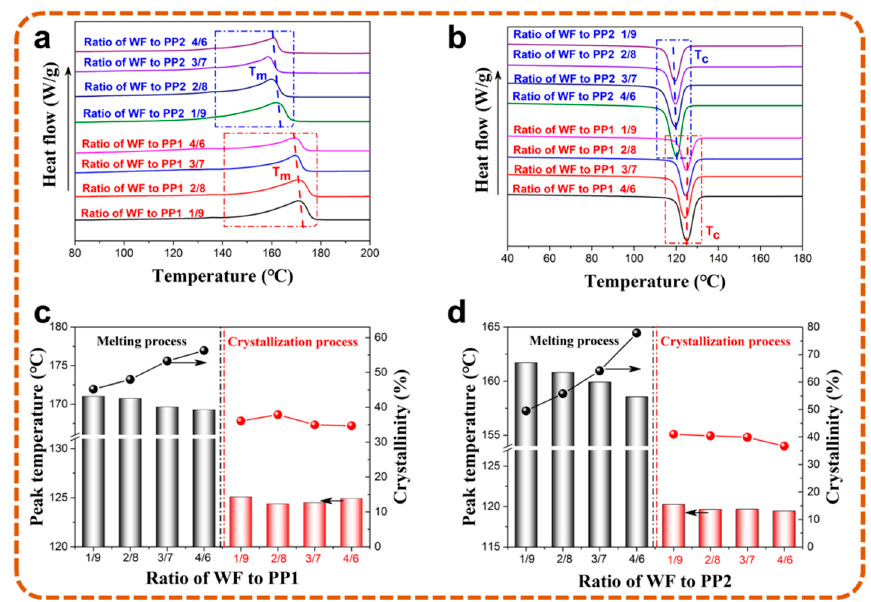
Figure 5. DSC curves ( a , b ) and thermal properties ( c , d ) of PP1 and PP2 based composites with different WF content.